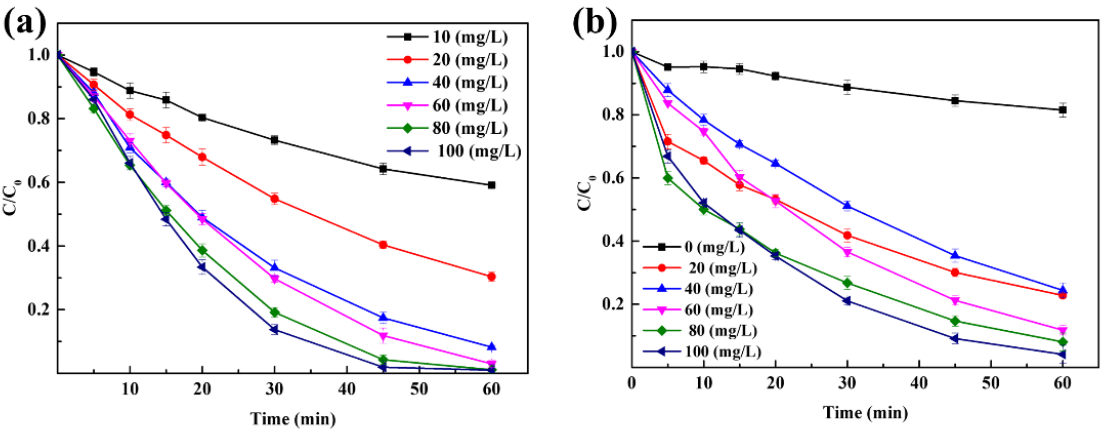
Figure 3. ( a ) Effect of PAA loading on Rhodamine B degradation (CuFe 2 O 4 = 100 mg/L, pH = 7, C 0 = 20 mg/L, room temperature for 1 h). ( b ) Effect of catalyst loading on Rhodamine B degradation (PAA = 80 mg/L, pH = 7, C 0 = 20 mg/L, room temperature for 1 h).